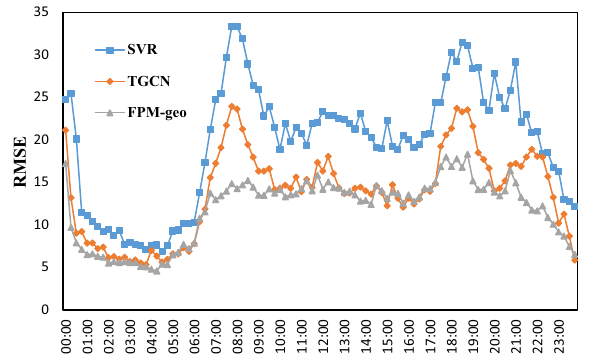
Figure 16. Time distribution of the RMSE of each model.